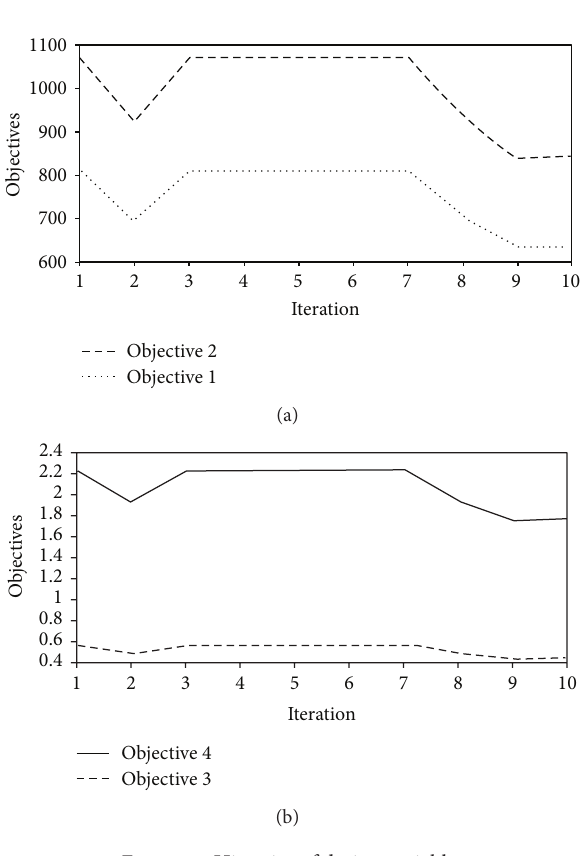
Figure 5: Histories of design